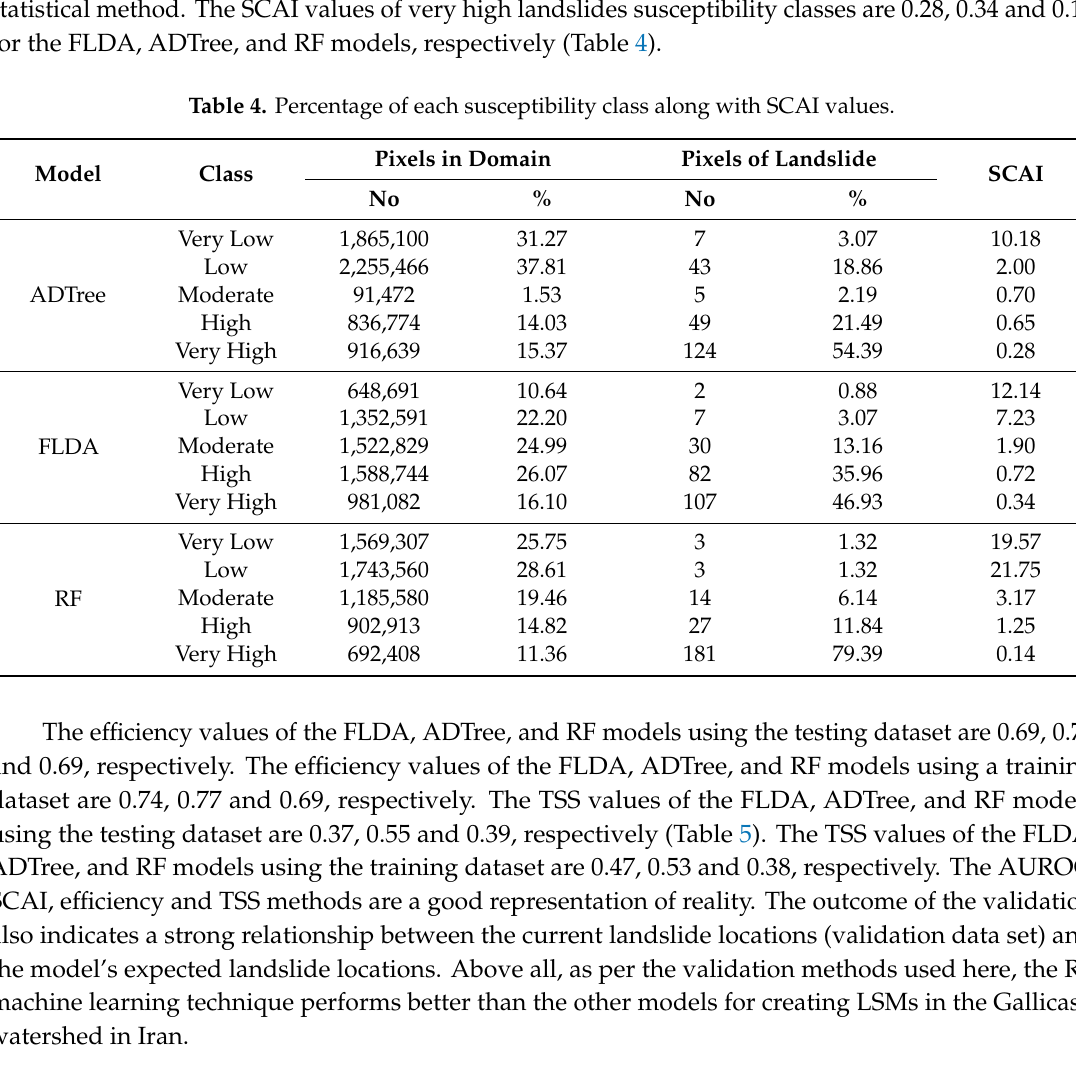
Table 5. Values of e ffi ciency (E) and true skill statistic